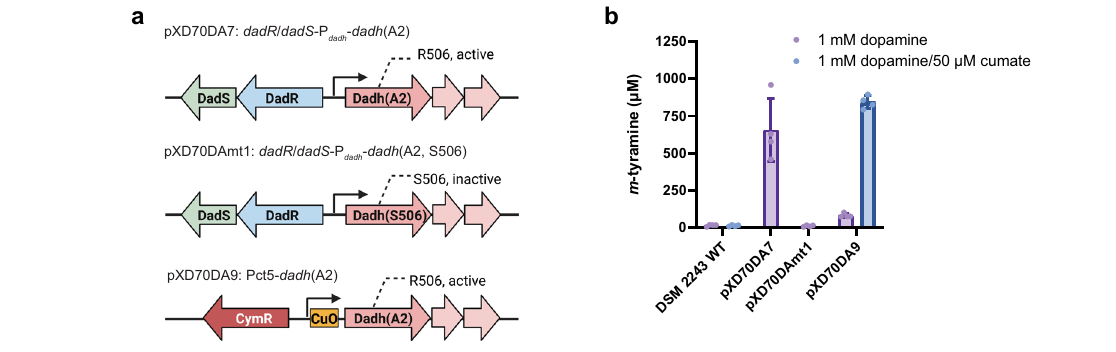
after incubation with corresponding E. lenta cultures for 48h. Data represented as mean±SD with n =4 biological replicates. Source data are provided as a Source Data fi